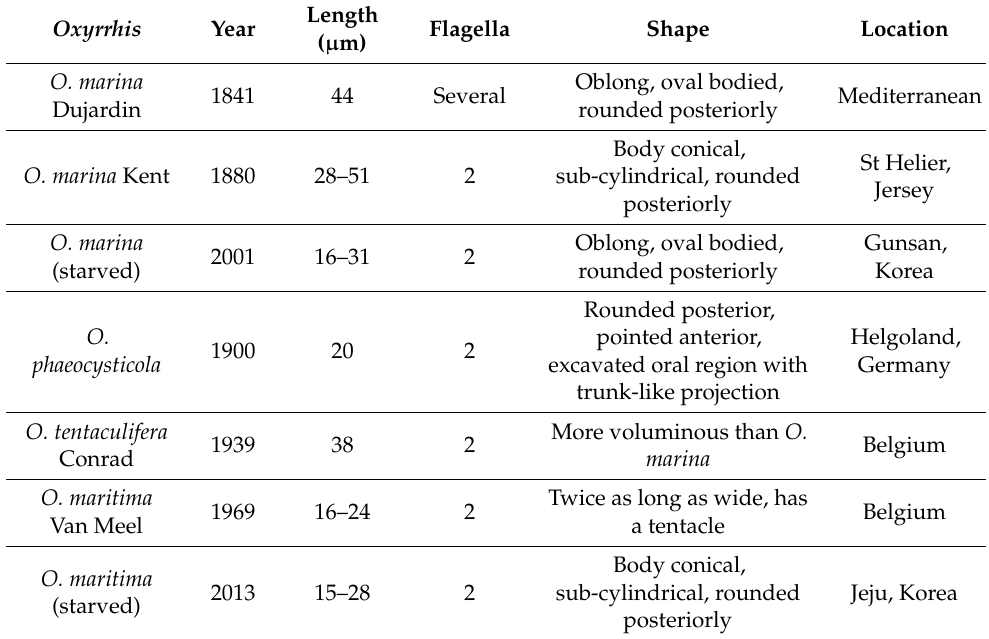
Table 1. The designations, and taxonomic authorities, for species in the genus Oxyrrhis